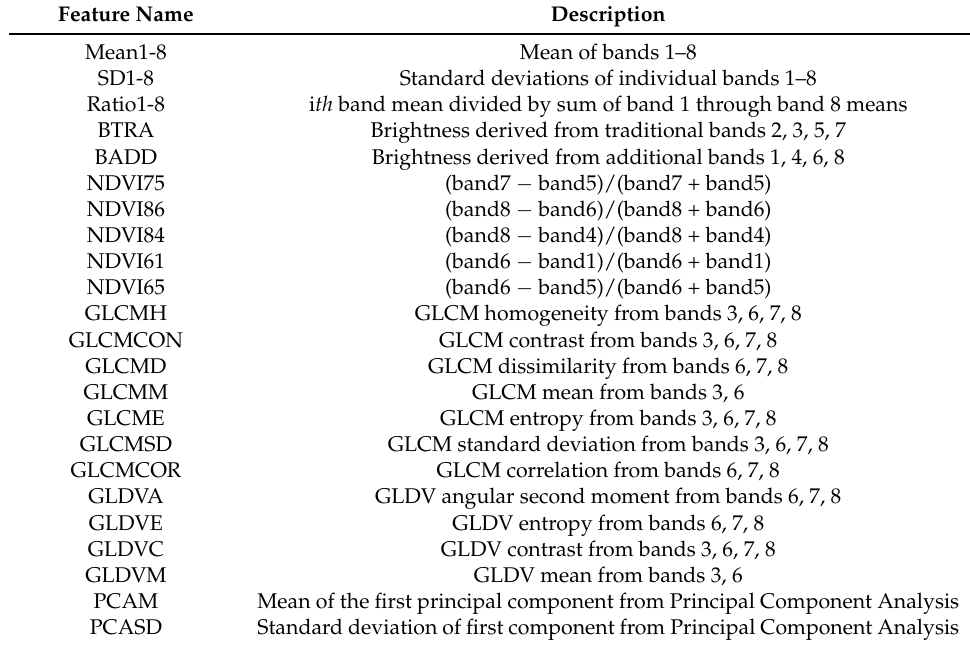
Table 5. Description of object features derived from WV2/WV3 images.